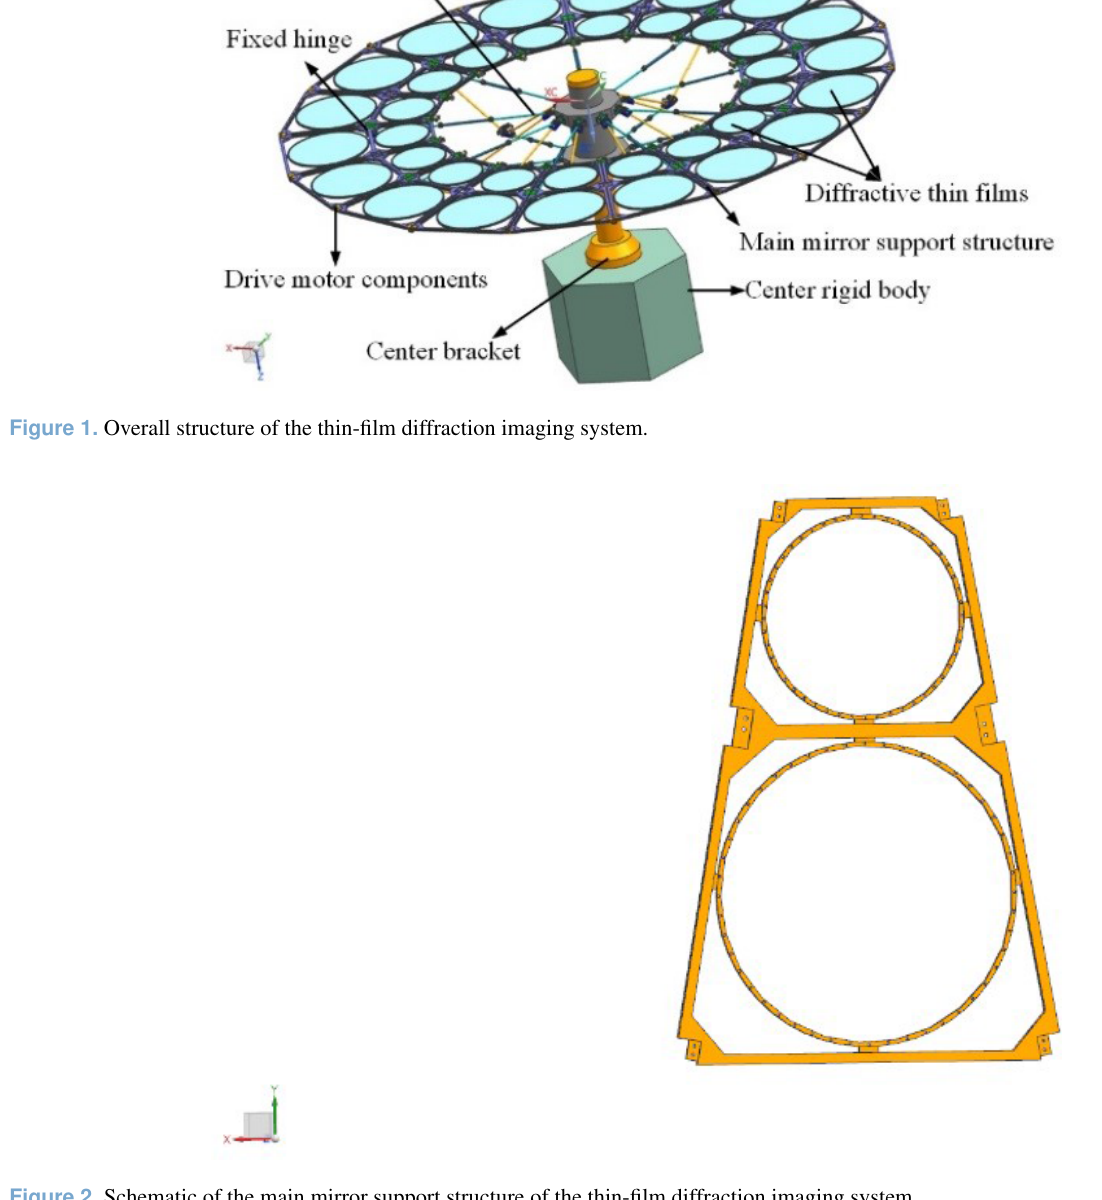
Figure 2. Schematic of the main mirror support structure of the thin-film diffraction imaging